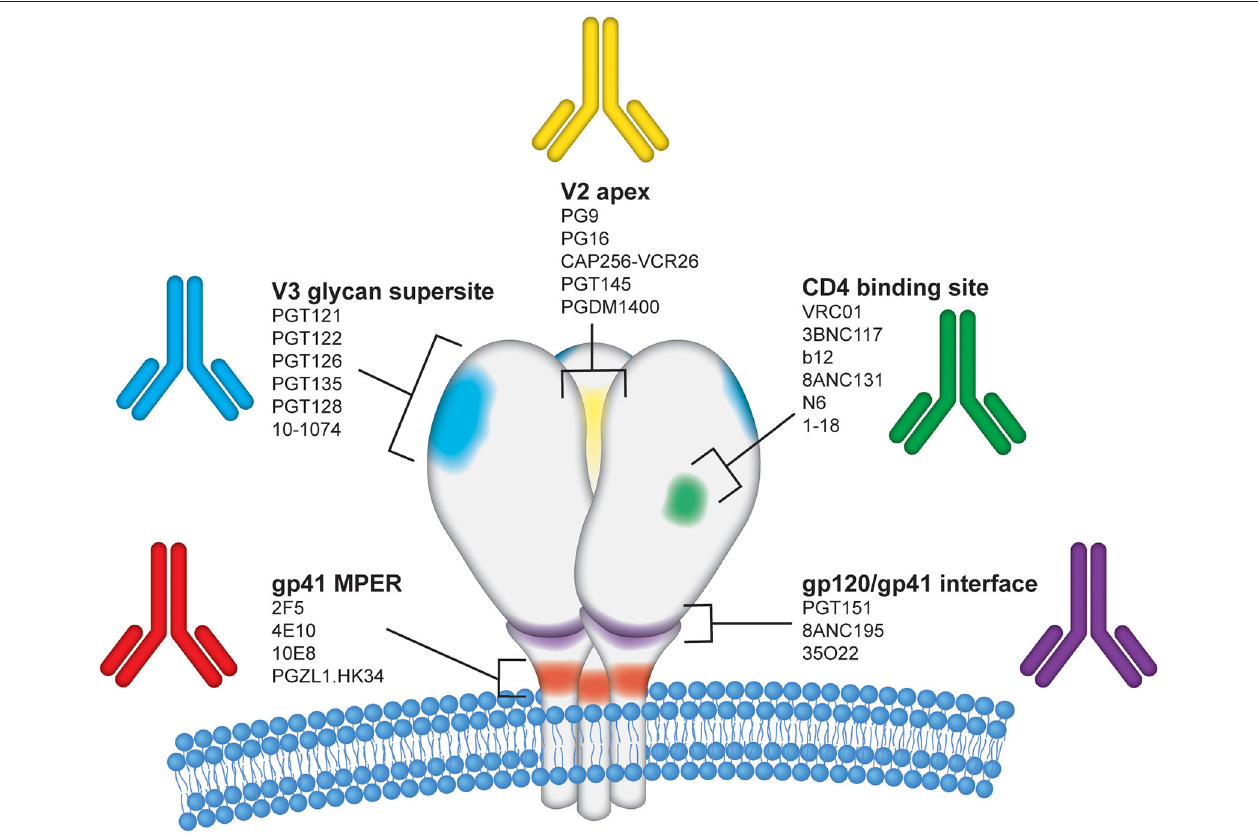
FIGURE 2 | Epitope regions on the HIV-1 Envelope targeted by bNAbs. The HIV-1 envelope glycoprotein (Env) is the sole target for bNAbs and is displayed on the surface of virions as a trimer of gp120 and gp41 heterodimers. Each of the three gp120 protomers are shown in white above the viral membrane with the three gp41 regions shown embedded within the viral membrane. For simplicity, glycans and variable regions on HIV Env are not depicted in this figure. The image is an artistic rendering to illustrate the five primary conserved epitope regions on the HIV Env surface proteins targeted by bNAbs. The epitope regions shown are labeled as follows: (1) V2 apex–yellow; (2) CD4 binding site–green; (3) gp120/gp41 interface–purple; (4) gp41 membrane proximal region (MPER)–red; and (5) V3 glycan supersite–blue. Several representative human monoclonal antibodies known to target each of these regions are